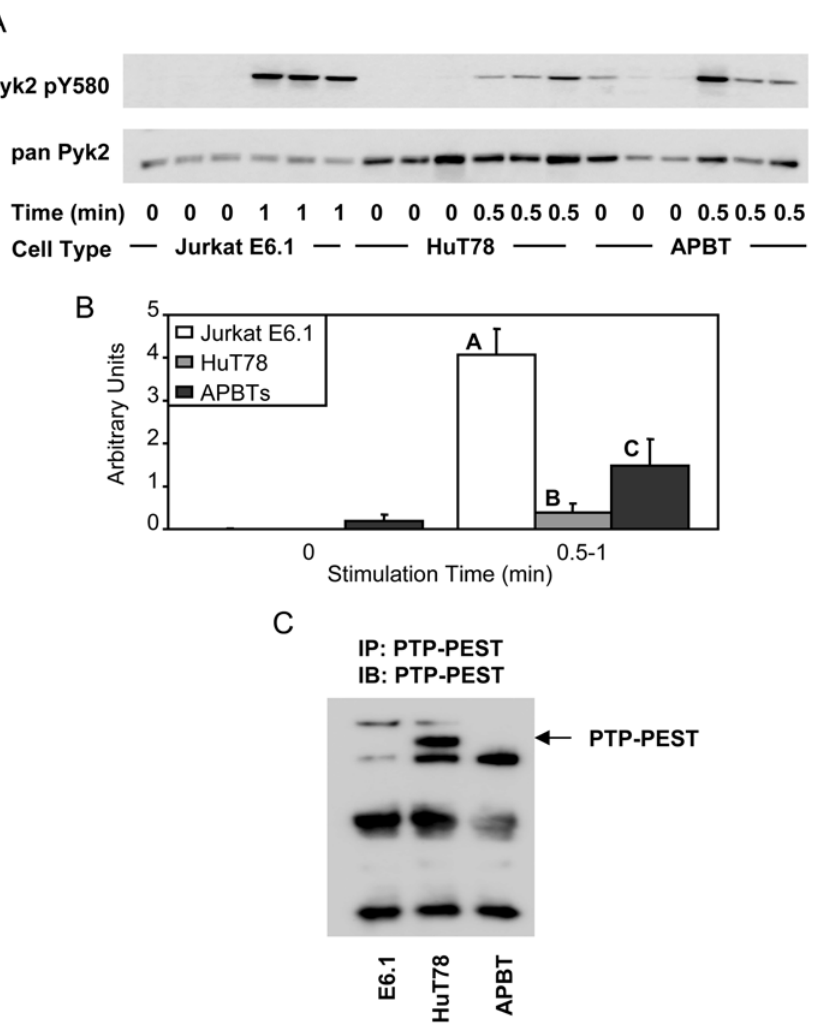
Figure 7. Jurkat E6.1 T cells, HuT78 T cells, and APBTs have different levels of Pyk2 Y580 phosphorylation. (A) Three samples of Jurkat E6.1 T cells, HuT78 T cells, and APBTs were stimulated and the cellular proteins were separated by SDS-PAGE. The site-specific phosphorylation and expression of Pyk2 was assessed by immunoblotting using Pyk2 pY580 (top) and pan-Pyk2 (bottom) antibodies. (B) The immunoblots were analyzed by densitometry and the ratio of the intensity of the phosphospecific Pyk2 band to the pan-Pyk2 band for each cell line was averaged. Letters represents significant differences of p , 0.05. (C) PTP-PEST was immunoprecipitated for Jurkat E6.1 T cells, HuT78 T cells and APBTs. The expression of PTP-PEST in the different T cells was assessed by immunoblotting.